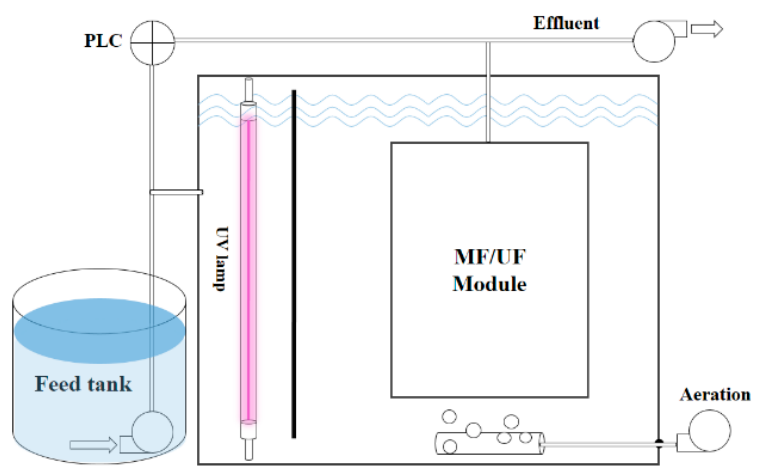
Figure 7. Experimental set-up diagram of photocatalytic membrane reactor.